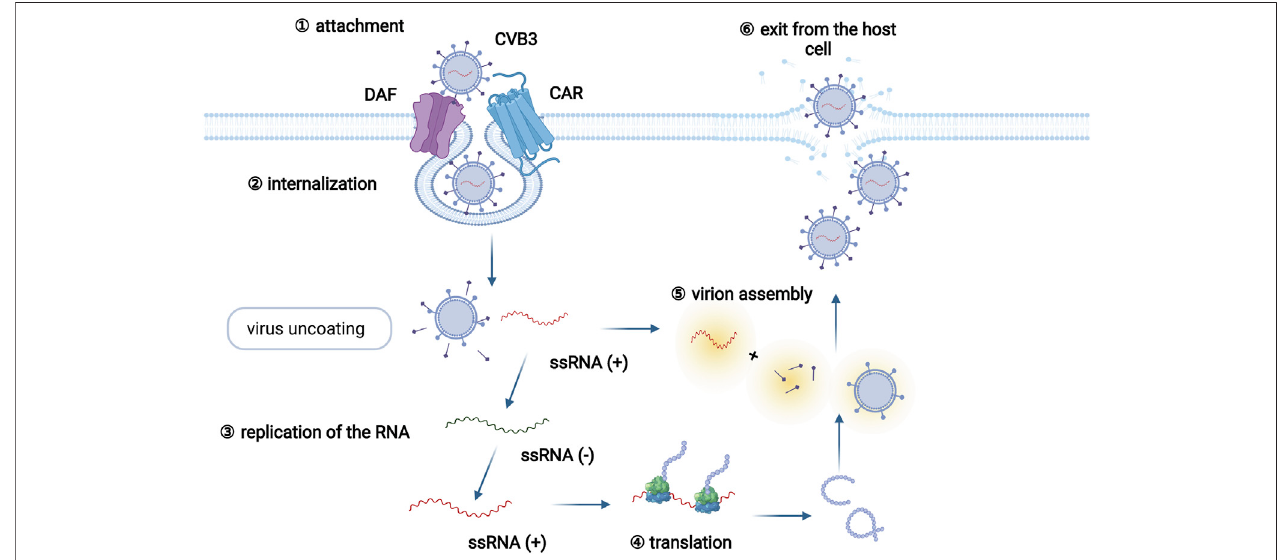
FIGURE1| TheCVB3 lifecycle.TheCVB3lifecyclemainlyinvolvessixdifferentstages: viralattachmenttothehostcell,penetration, RNAgenomereplication,viral protein translation, assembly of virions, and exit from the host cell. Speci fi cally, CVB3 infection begins by the coupling of decay-accelerating factor (DAF, primary attachment protein or coreceptor) and coxsackievirus and adenovirus receptor (CAR, internalization receptor) on host cells. Virus binding to CAR facilitates virus internalization. Following internalization and virus uncoating, the positive-sense RNA of CVB3 enters the cytoplasm and serves as a template for the translation of viral polyprotein. Subsequently, the newly synthesized polyprotein iscleaved intoseveralstructuraland functionalproteins. Togetherwiththe positiveRNA strands, new virions are assembled and released as progeny viruses to initiate new rounds of infection.